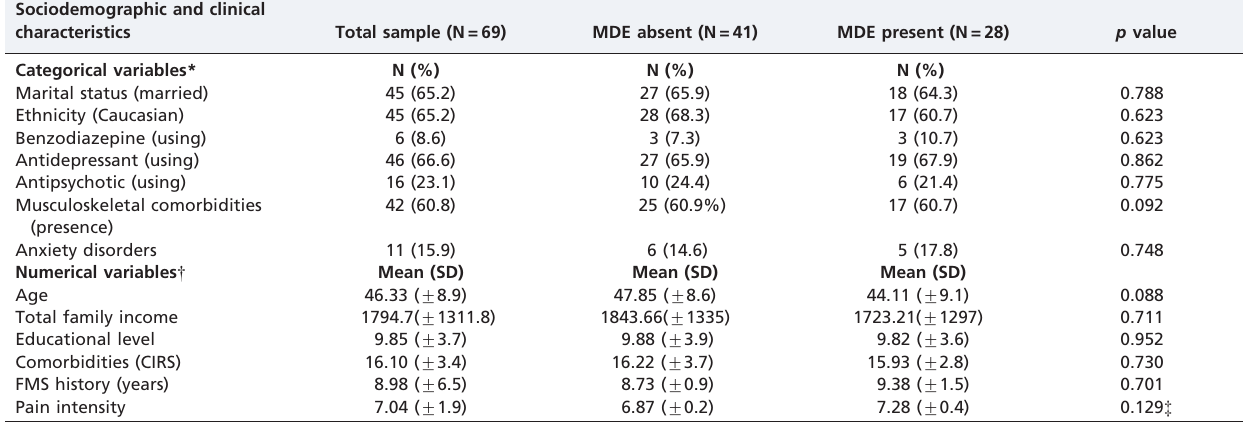
Table 1 - Sociodemographic and clinical characteristics of female FMS patients with and without a current major depressive episode.